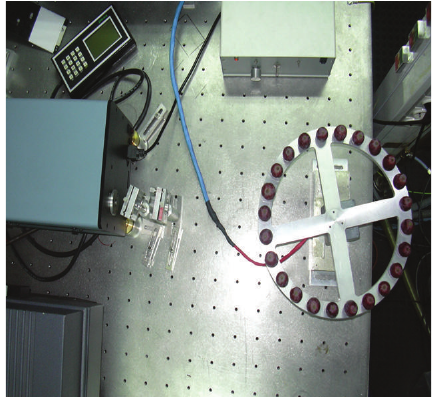
F 1: Grapes laser irradiation set-up. Individual grapes over an external crown of a disc of 30cm diameter. Irradiation was provided through a dye laser (Continuum ND60), which was used to pump an INRAD-AT-III-UV frequency-doubling unit whose (BBO-TST) crystal allows scanning the output from 235nm to